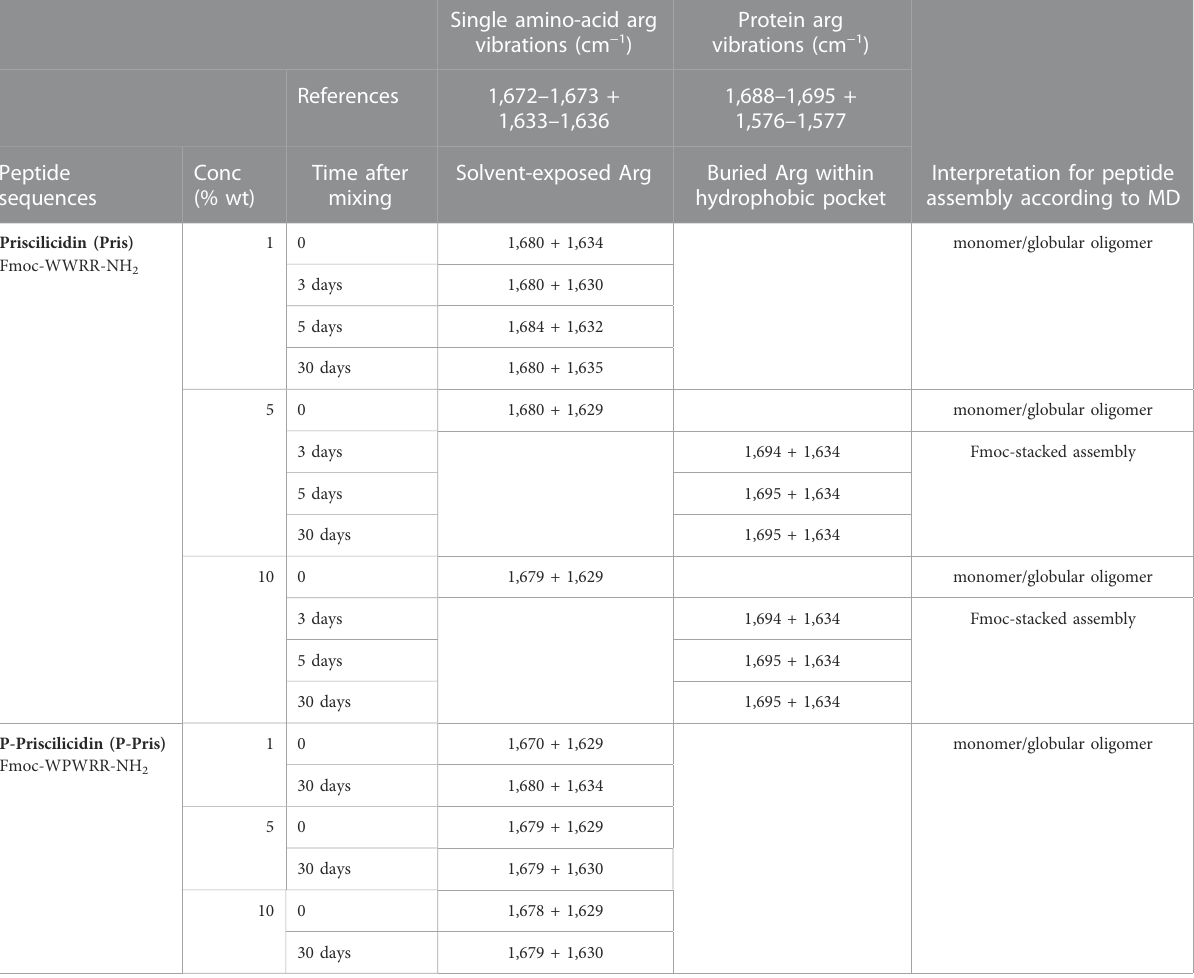
microscopy, and oscillatory rheology (Figure 6; Supplementary Figure S32). For incubation times of a few days, Priscilicidin